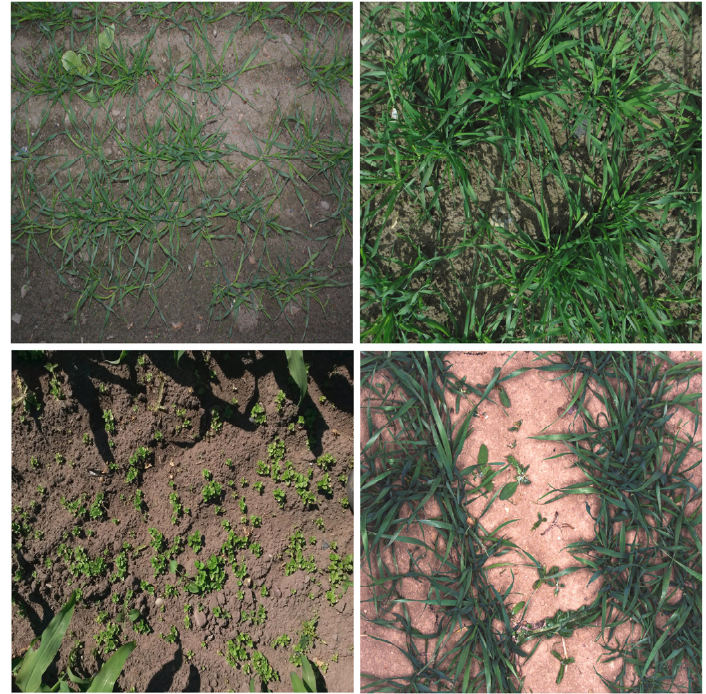
Figure 2. The acquired images in situ.